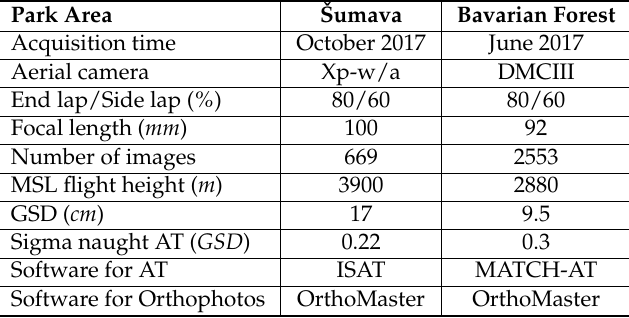
Table 2. Flight parameters of aerial image acquisition, results of subsequent aerial triangulation, and software packages